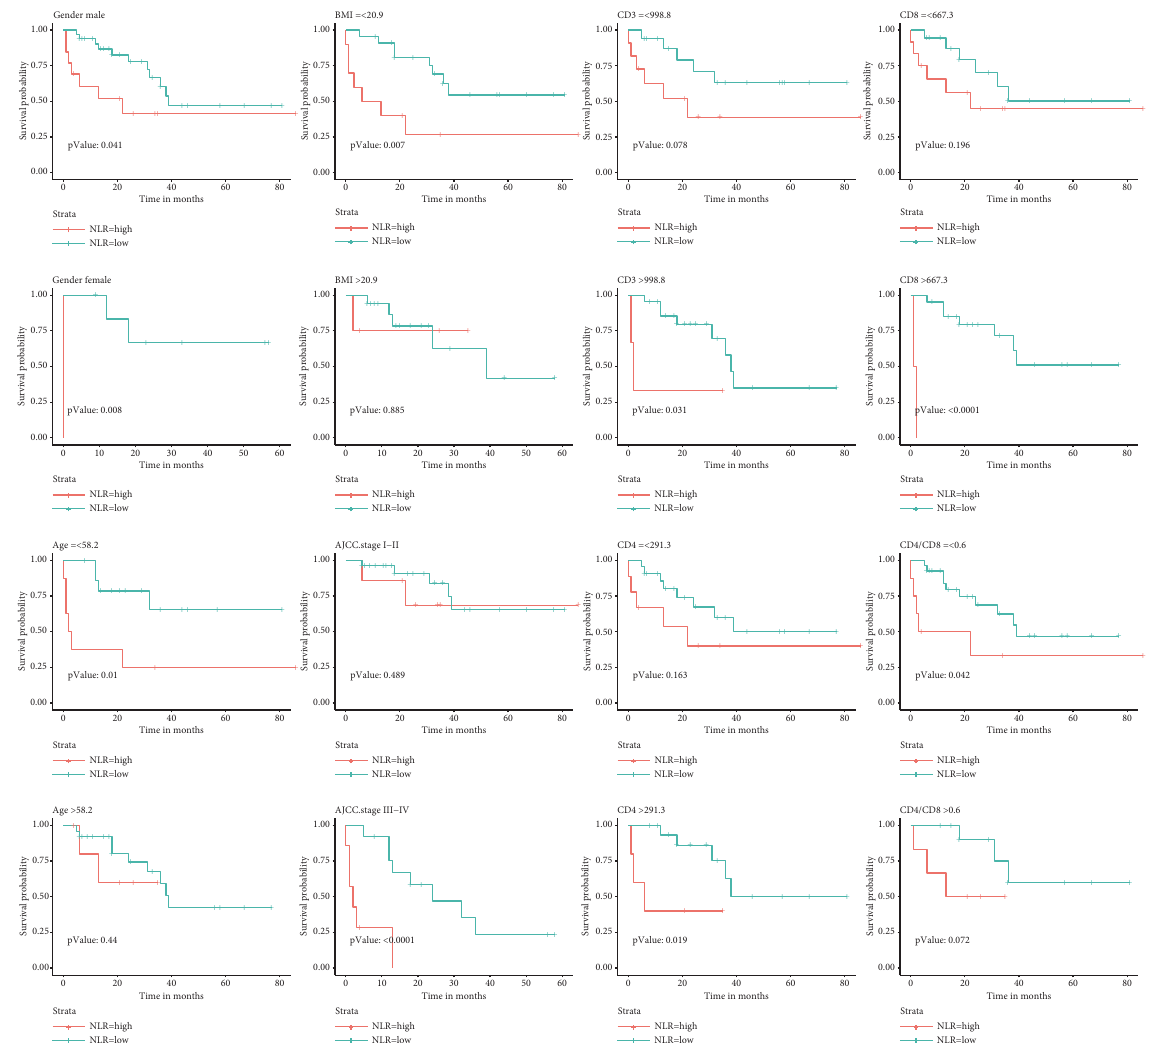
Figure 2: Analysis of OS based on gender, age, BMI, AJCC stage, CD3+ T lymphocytes counts, CD4+ T lymphocytes counts, CD8 T lymphocytes counts, and CD4/CD8 ratio in NLR